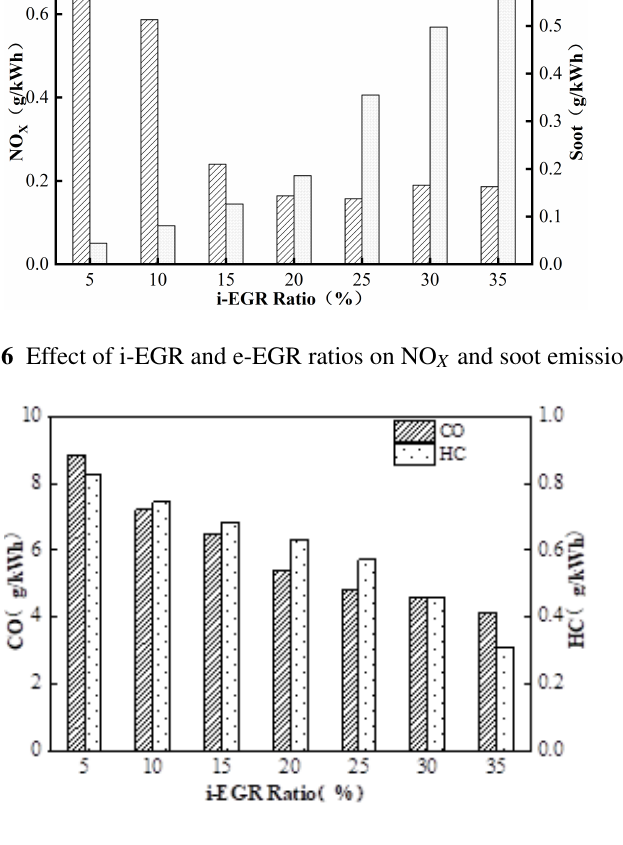
Fig. 17 Effect of i-EGR ratio on CO and HC